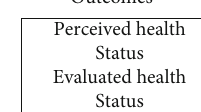
Figure 1: Anderson ’ s Behavioral Model of Health Services.